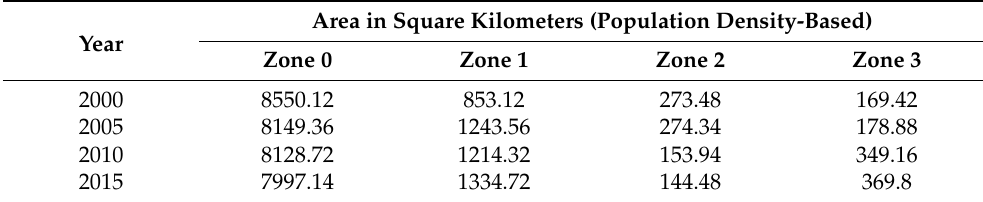
Table 6. Area Calculation for the Representative Years When Population Density is Considered.